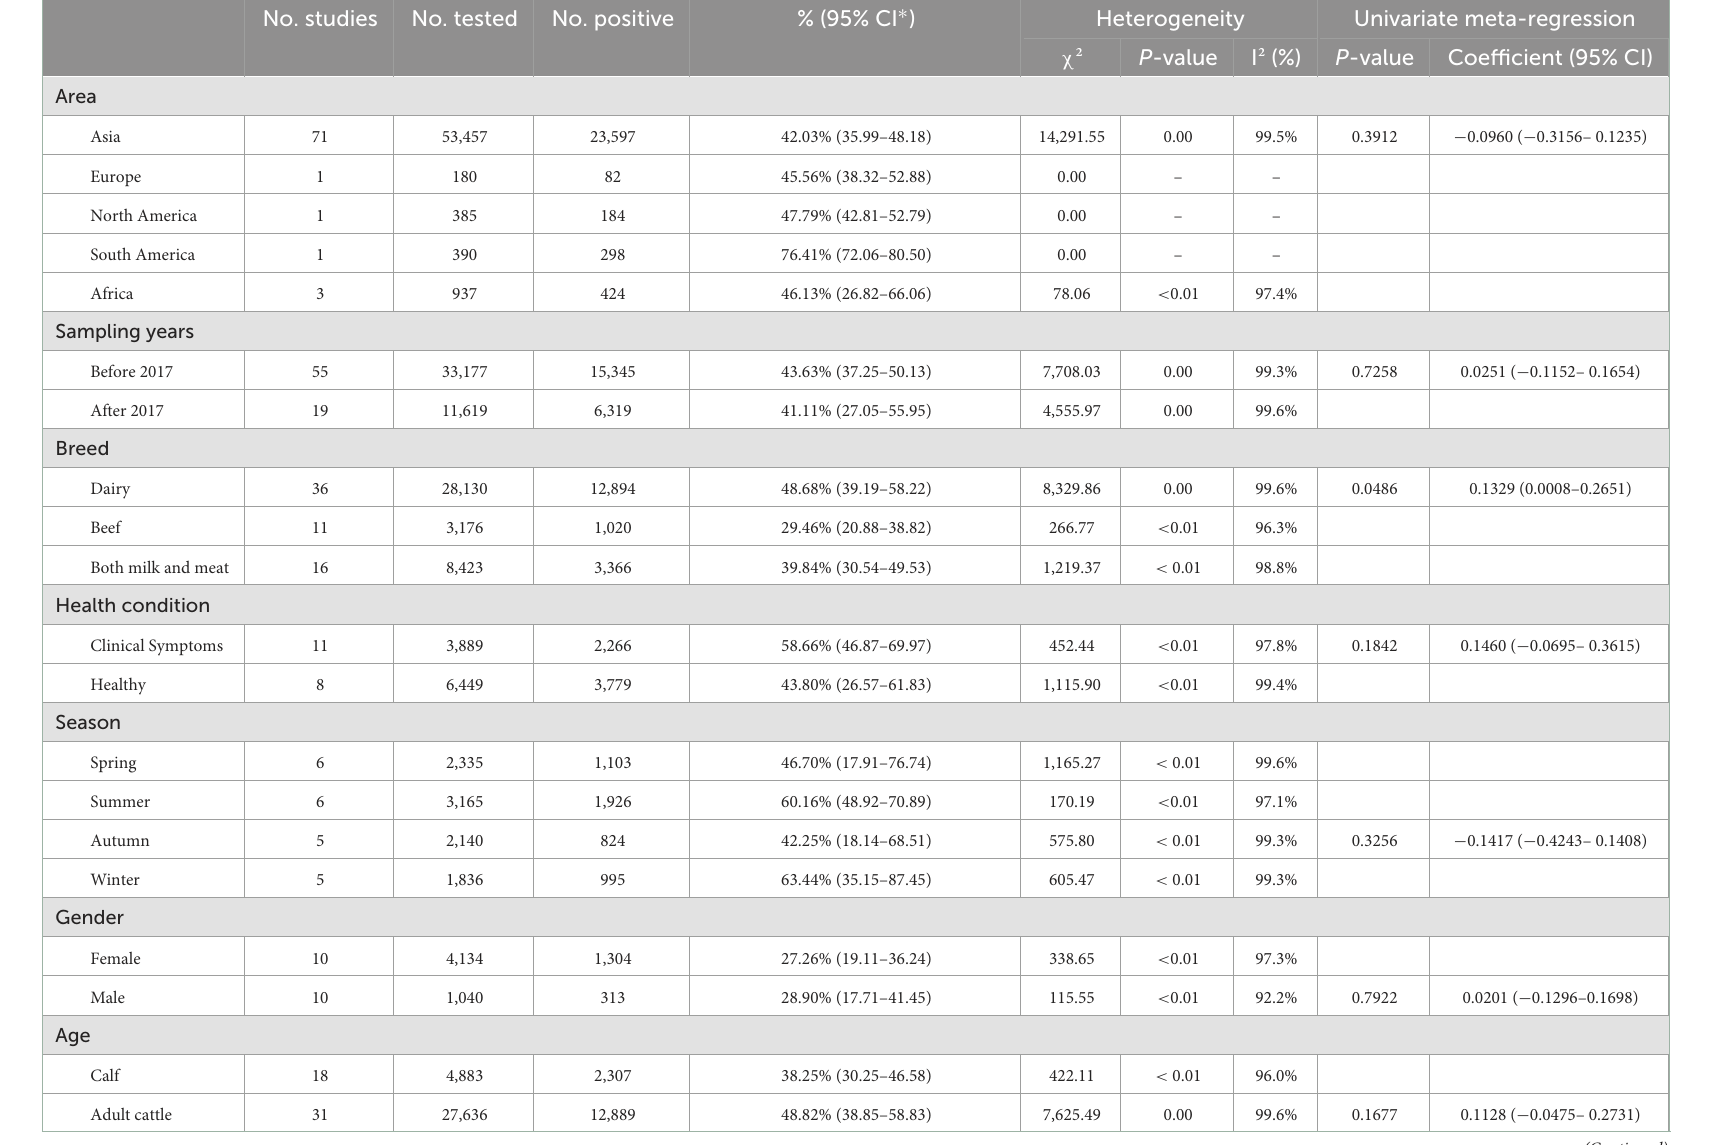
TABLE 4 Antibody prevalence of Bovine viral diarrhea virus of cattle in the word. No. studies No.